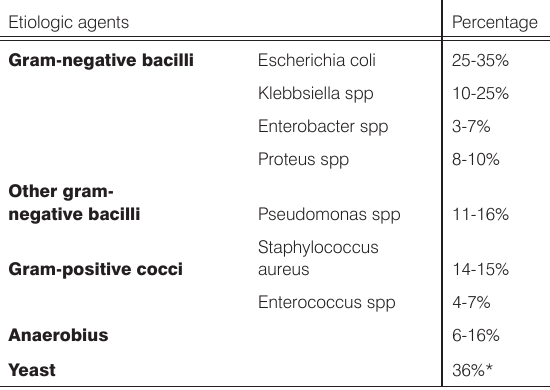
Table 4. Etiologic agents in infected acute